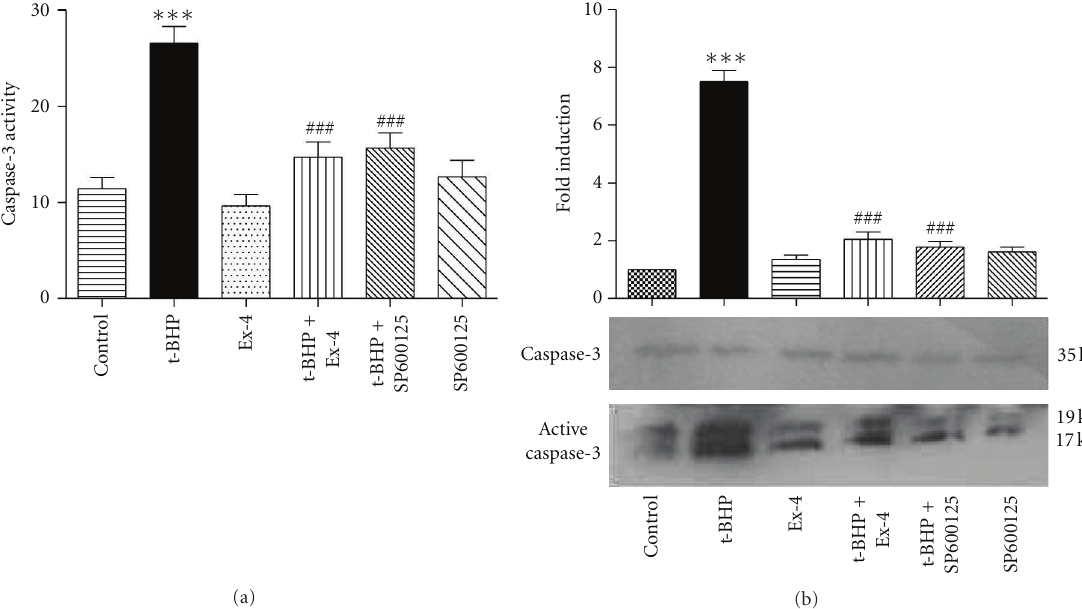
Figure 2: Exendin-4 inhibits caspase-3 activity in t-BHP-treated MIN6 cells. MIN6 cells were preincubated with exendin-4 (100nM) or with SP600125 (10nM) for 18h and then exposed to t-BHP (25 μ M) for 1 h. Caspase-3 activity was determined using a caspase-3 activity assay (a) and western blotting (b), as described in Section 2. The histogram shows the quantification of the protein data. Levels of active caspase-3 protein were normalized to caspase-3 levels and expressed as the relative fold change compared to the control samples. Values are expressed as the mean ± SD ( n = 3). ∗∗∗ P < 0 . 001 versus control group; ### P < 0 . 001 versus the t-BHP group.